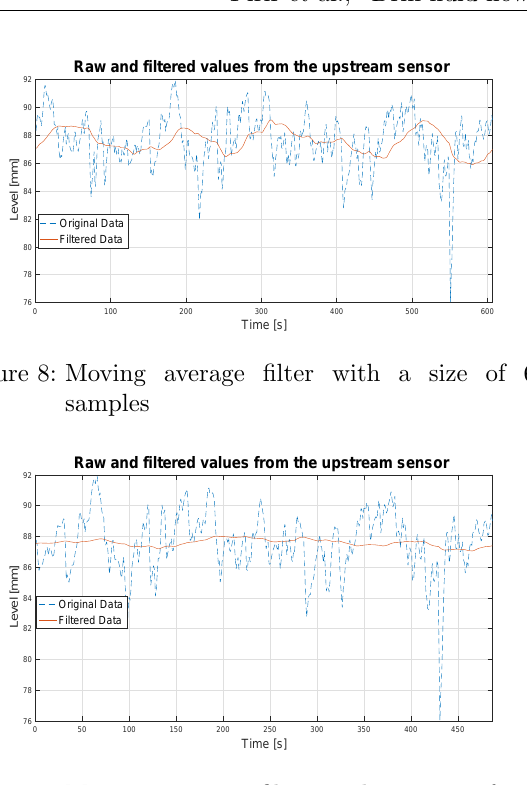
Figure 9: Moving average filter with a size of 180 samples